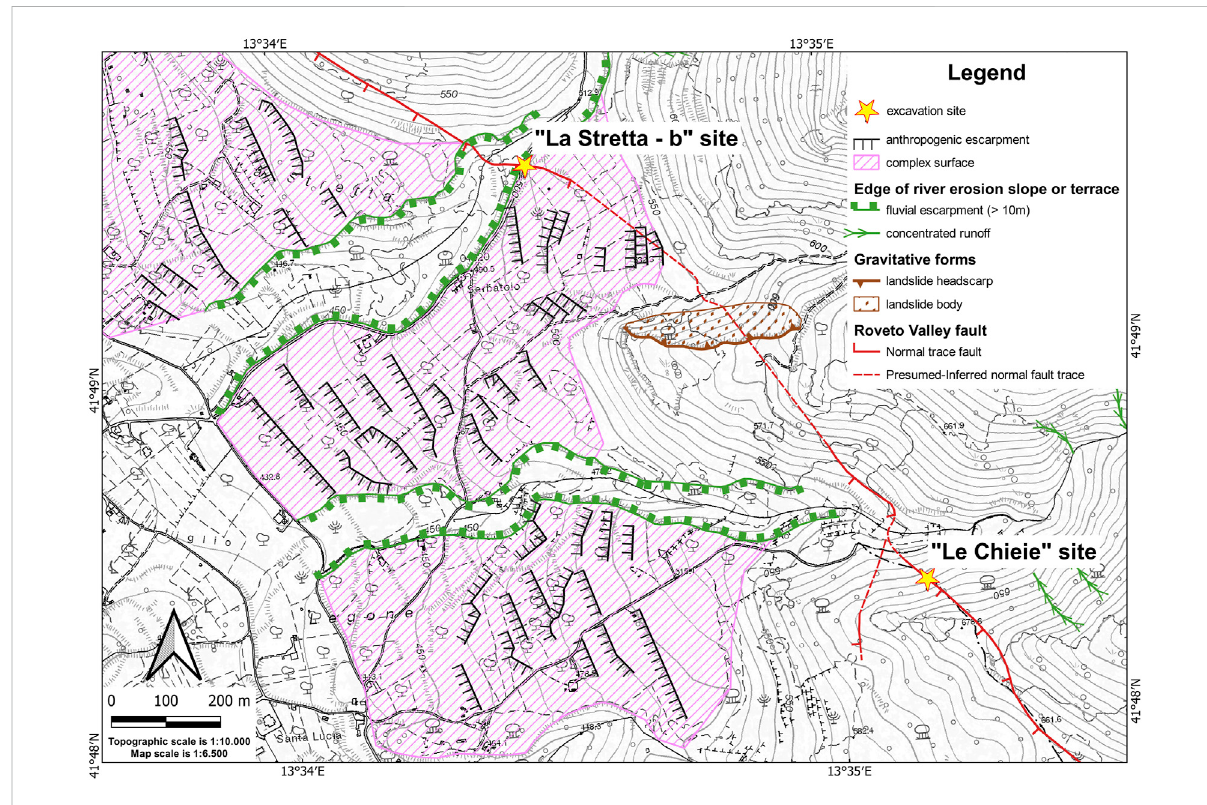
FIGURE 6 Geomorphologicschemeofthe “ LaStretta-b"and “ LeChieie ” sites.Topographicmap(scale1:10.000)fromopengeodataoftheAbruzziRegion